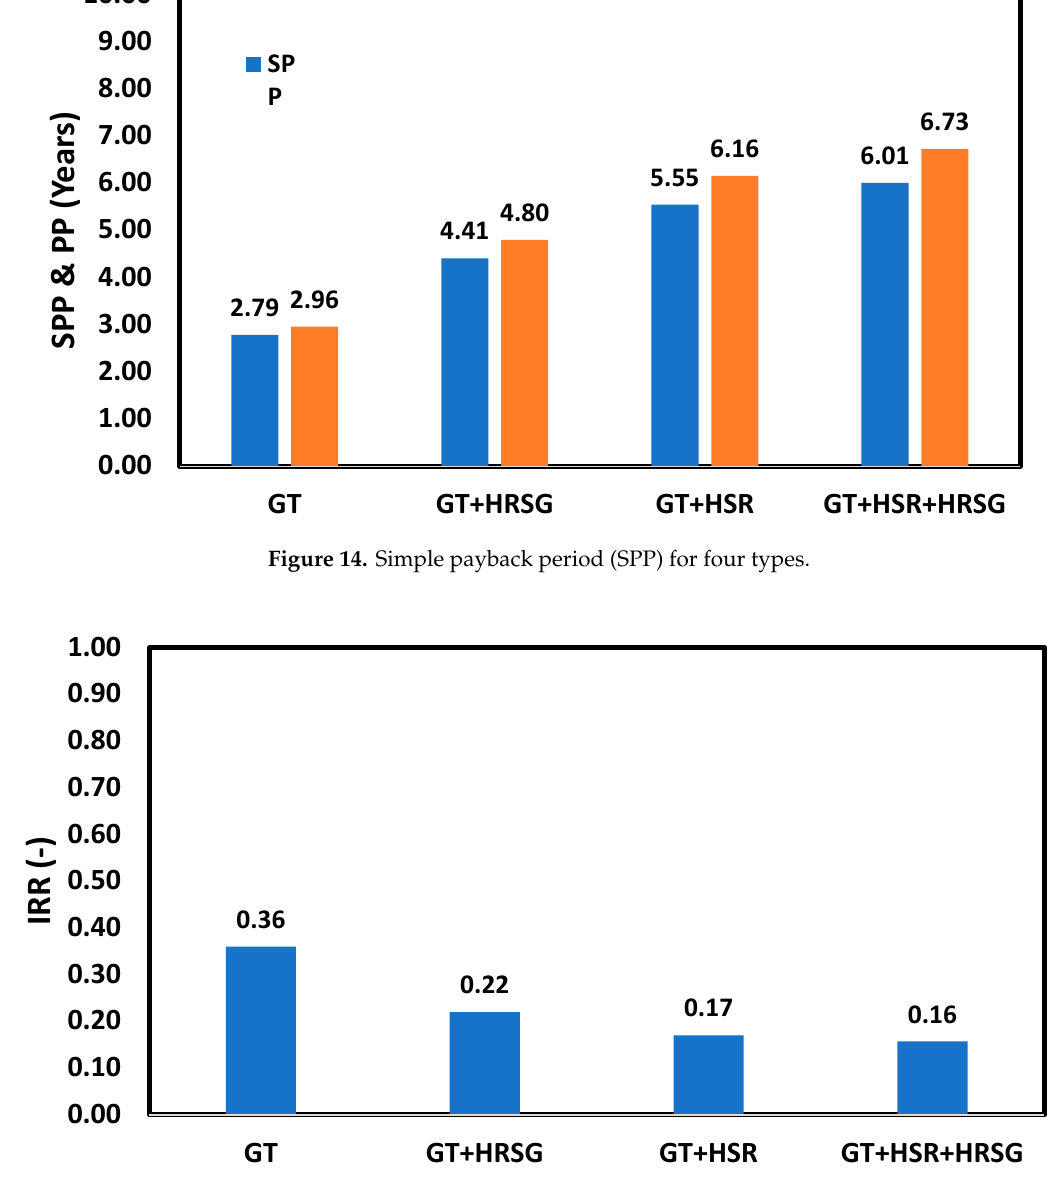
Figure 15. Internal rate of return (IRR) for four types.